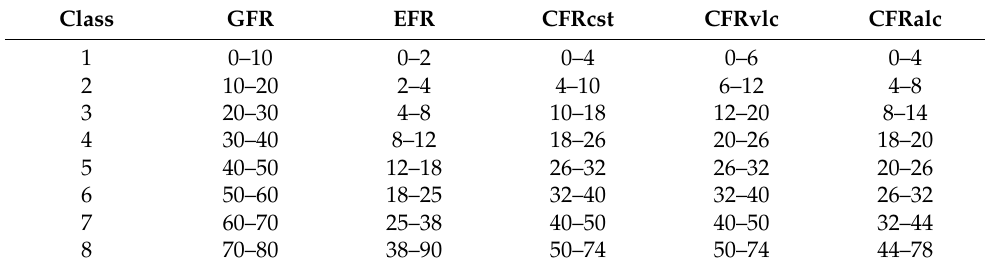
Table 5. Intervals defined for slope according to methodologies and provinces described in the text. Values in sexagesimal degrees.